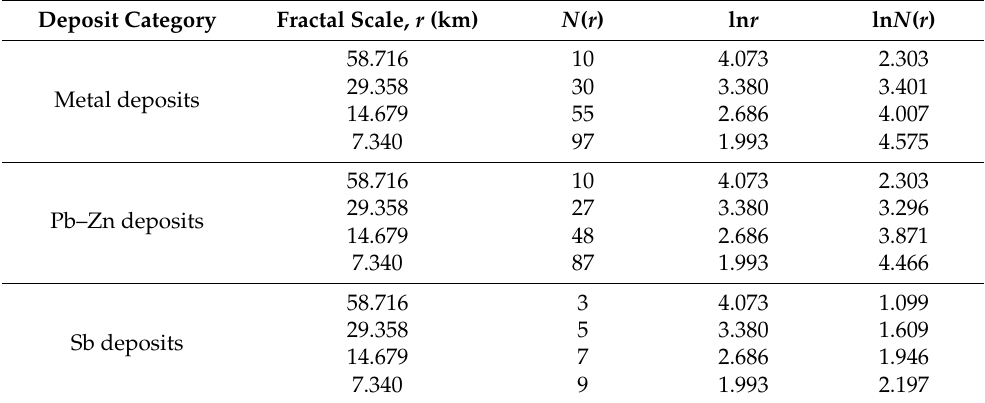
Table 9. Statistical table of calculation parameters for the spatial distribution fractal dimensions (SDD) of